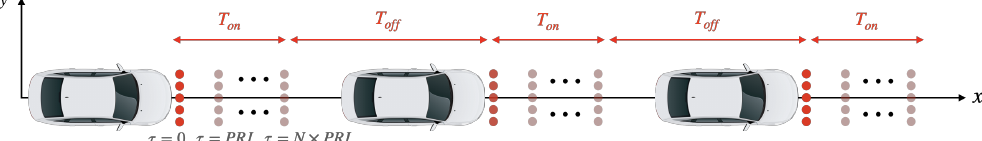
Figure 4. Burst acquisition mode representation: while the vehicle is moving the radar works for a period of time T on = N PRI , where N is the number of slow time samples for each burst, and it is × silent for a period of time T of f